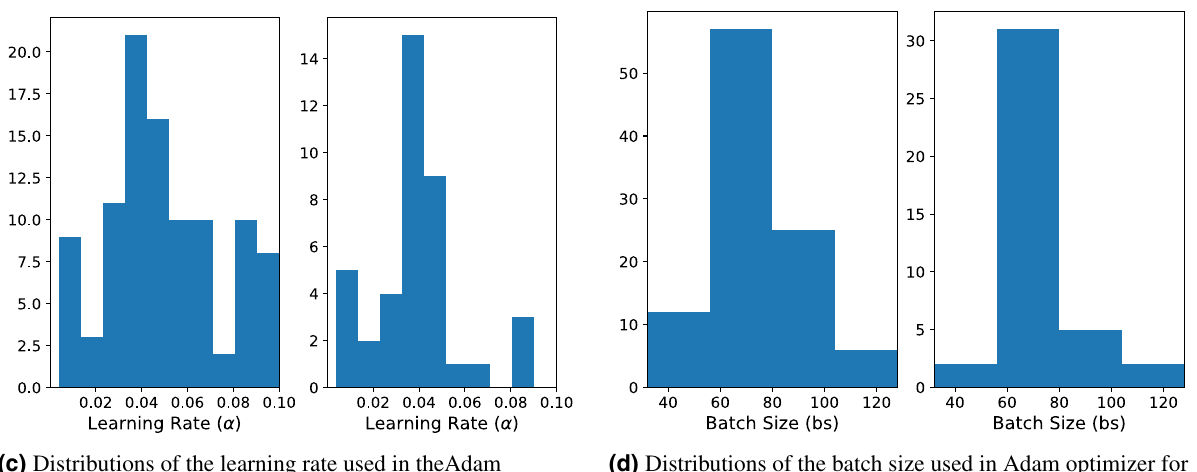
Figure 5. In all figures, the distributions on the left represent the total distribution of the hyperparameter explored by the Bayesian hyperparameter optimizer. In contrast, the distributions on the right in each figure indicate the distribution of the hyperparameter conditioned on the objective functional value being within 5% of the maximal theoretical